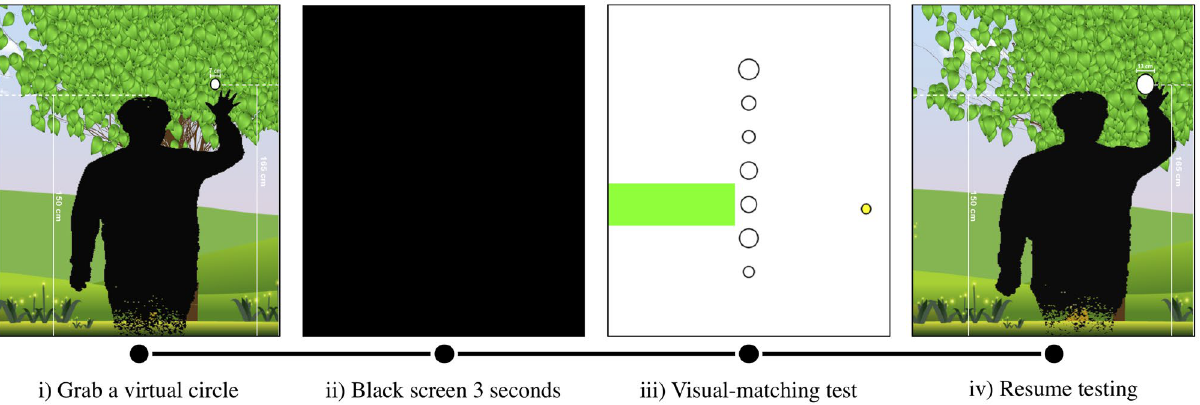
Figure 4. Procedures for the VR perception tests. ( i ) Participants grab a virtual circle. ( ii ) A black screen appears for three seconds. ( iii ) Participants select a circle (i.e., grab a circle) that visually matches the circle they grabbed. ( iv ) Participants continue the test.